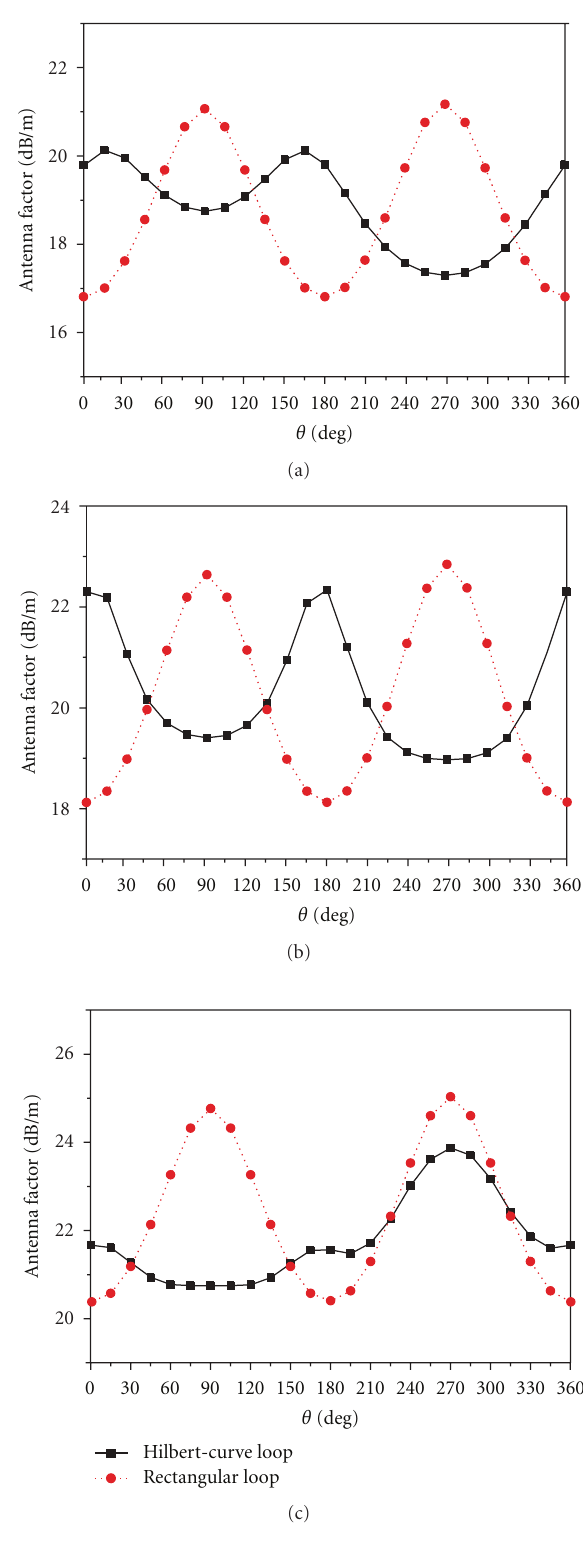
Figure 13: Variation of the antenna factor K at φ = 90 ◦ ( yz - plane) for the proposed flexible Hilbert-curve loop antenna and rectangular loop antenna. (a) 2.45GHz, (b) 3.35 GHz, and (c)